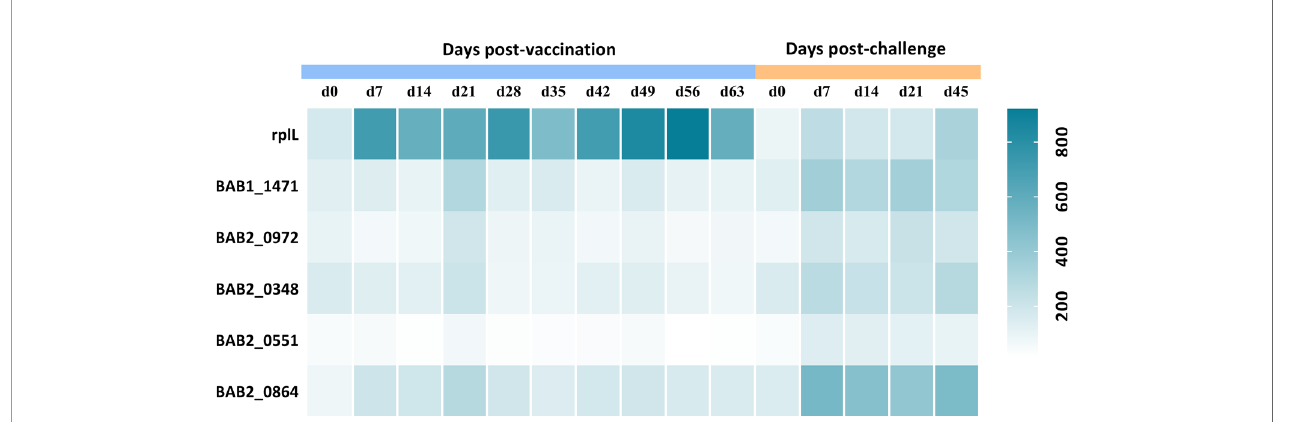
FIGURE 4 | IgG response of 5 proteins obtained from sera of cattle inoculated with A19 D virB12 or S2308 at different time points. Values were expressed as average signal intensity of IgG